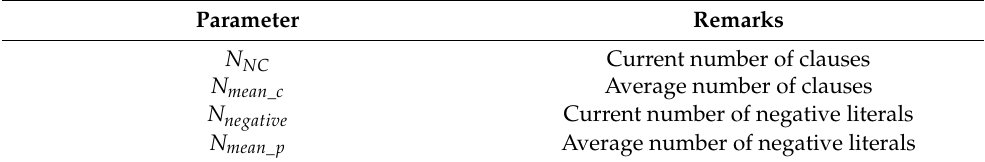
Table 5. Parameters involved in structure